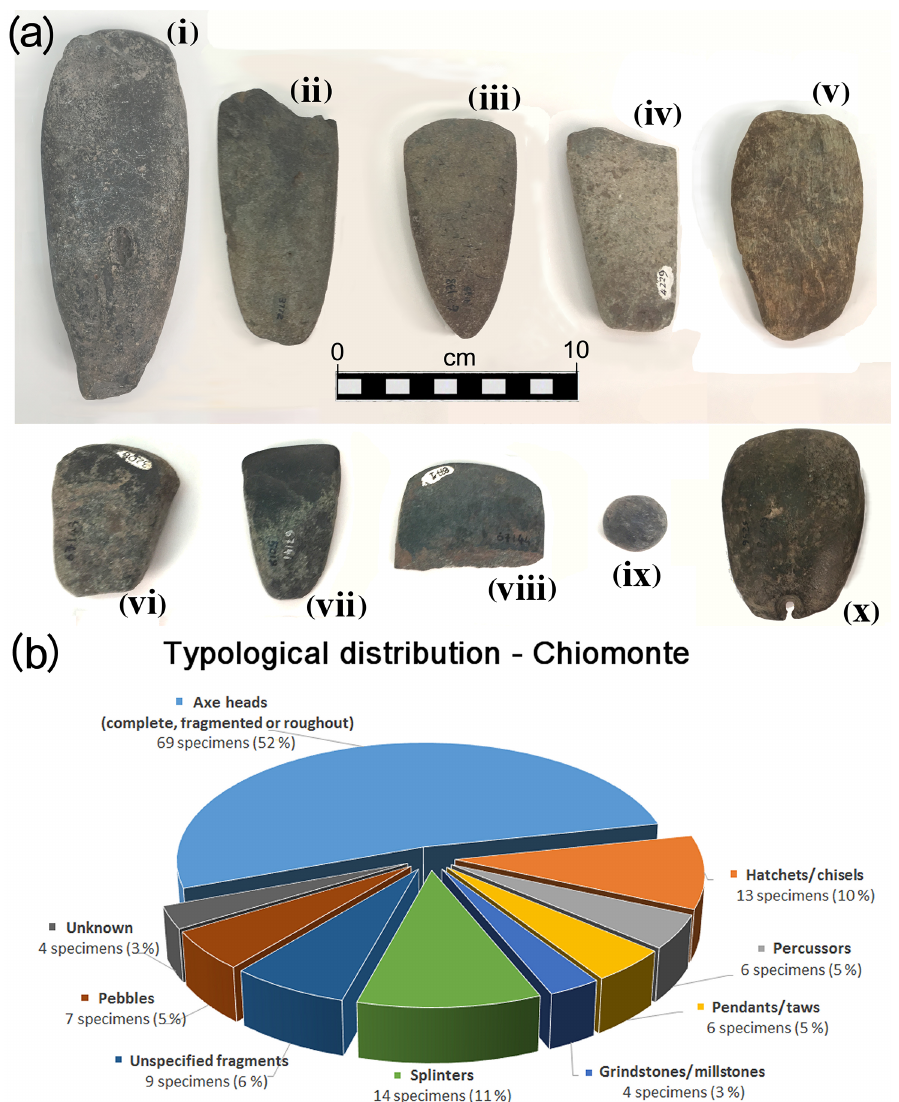
Figure 2. (a) Examples of Neolithic tools from Chiomonte: (i) 67140/3600 (axe head, serpentinite), (ii) 3772 (axe head, eclogite), (iii) 67138/4148 (axe head; jadeitite with albite?), (iv) 4229 (axe head, mixed Na pyroxenite, (v) 86453/1000 (pendant, chloritite; stud- ied with XRPD), (vi) 67143/3208 (small axe head, mixed Na pyroxenite), (vii) 67141/5018 (small axe head, mixed Na pyroxenite and eclogite), (viii) 67144/8771 (axe fragment, mixed Na pyroxenite), (ix) 67161/5117 (taw, serpentinite) and (x) 86451/3256 (pendant, chlo- ritite; studied with XRPD) (other details are reported in the Supplement Table S1). (b) Diagram reporting the functional distribution of the polished stone tools from the archaeological site of Chiomonte, based on results from morpho-typological studies.